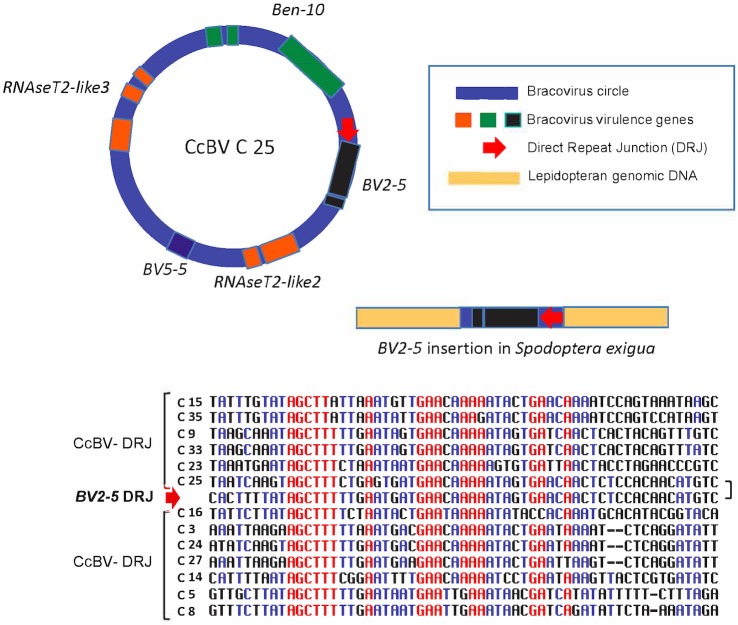
Regulatory sequence involved in bracovirus circle production retained in a bracovirus insertion in Spodoptera exigua genome.In the insertion containing BV2-5, a sequence (BV2-5 DRJ) downstream of the gene strongly resembles C25 DRJ of CcBV (C25). A schematic representation of the C25 circle and the BV2-5 insertion in Spodoptera exigua genome (not to scale). An alignment of BV2-5 DRJ with DRJ sequences of 12 CcBV circles (including C25) is shown below. Note that the DRJ in the lepidoptera is in the same relative position as in C25 and that the similarity between C25 DRJ and the BV2-5 insertion extend beyond (residues in black) the most conserved region of the CcBV DRJs (residues in red). The presence of this DRJ sequence, which is important for bracovirus life cycle (production of DNA circles packaged in the particles), is a signature that the sequence originated from a bracovirus and shows that the direction of the transfer was from bracovirus to Lepidoptera.